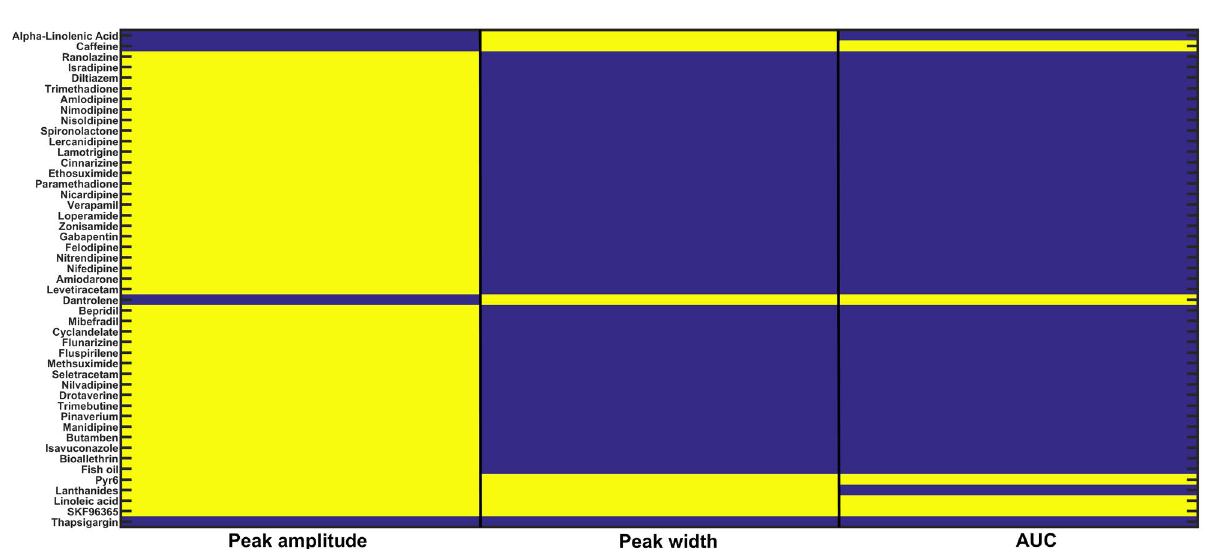
Figure 7. In silico drug screening: 47 calcium-related drugs were screened on the basis of the CRD restoration approach built-in the previous section. Three readouts namely, peak amplitude, peak width, and AUC were evaluated for each drug. The yellow color for a particular readout shows that it is in the range of CRD for the Doxo 3 + corresponding drug combination therapy and the blue color shows that it is not in the range of